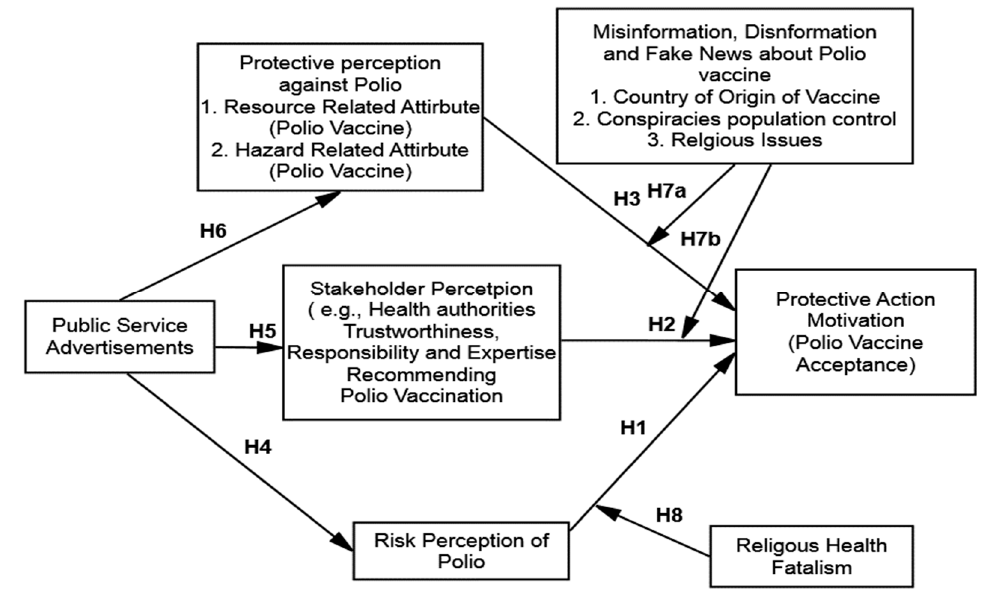
Figure 1. Conceptual model of the study .